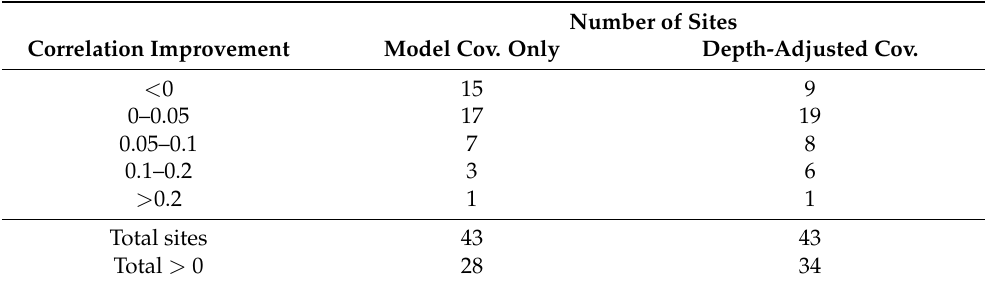
Table 1. Improvement in correlation coefficient with in situ BPR provided by the downscaling procedure without and with the depth adjustment, 3–12 month